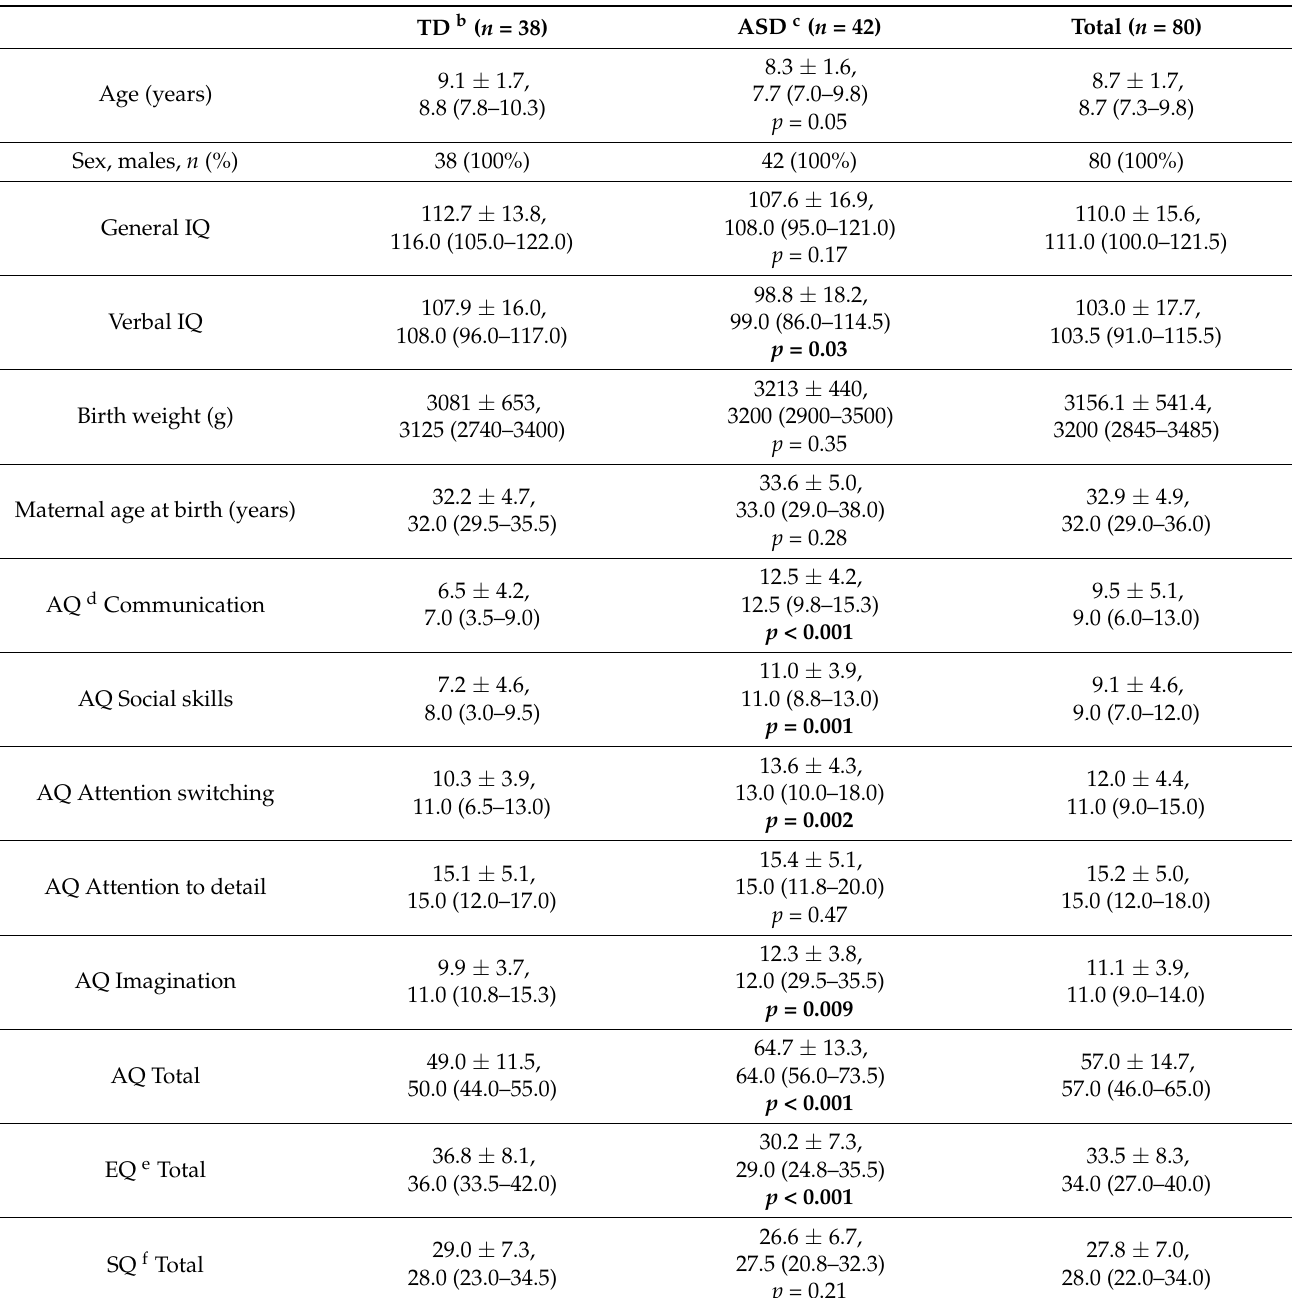
Table 1. Descriptive characteristics a of the study